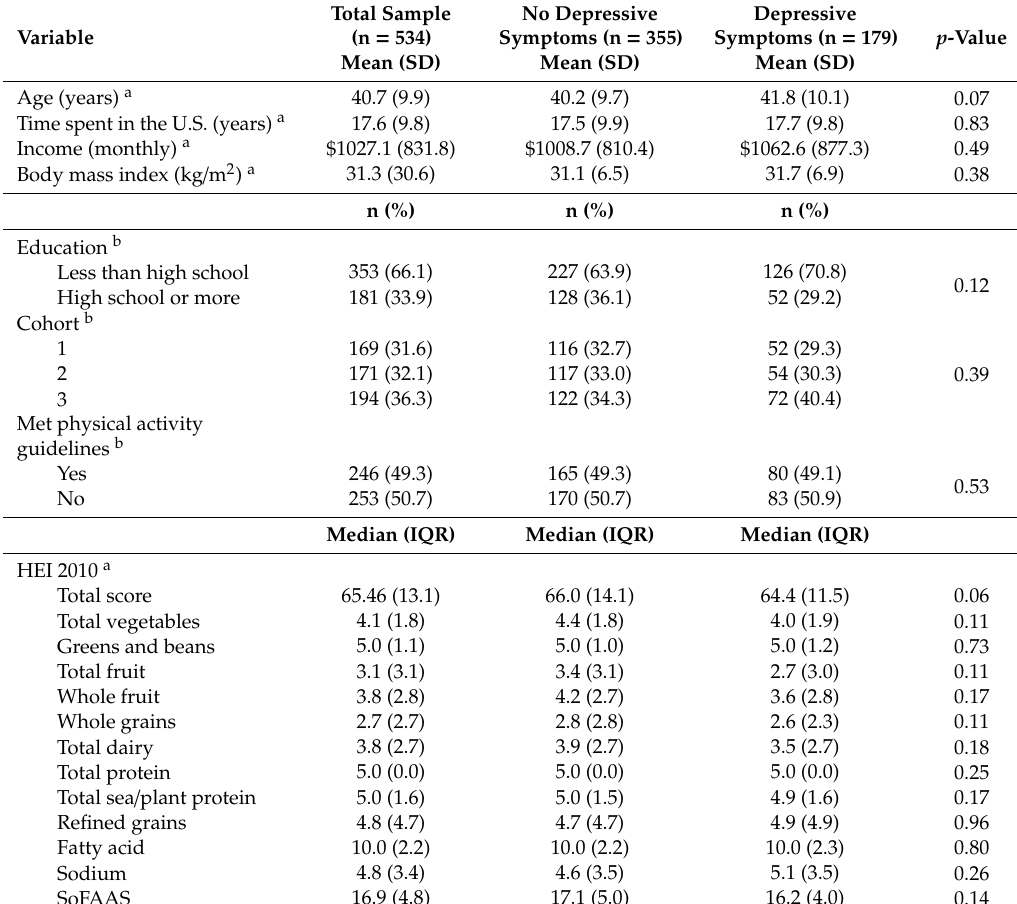
Table 1. Characteristics of Enlace Study sample by depressive symptom